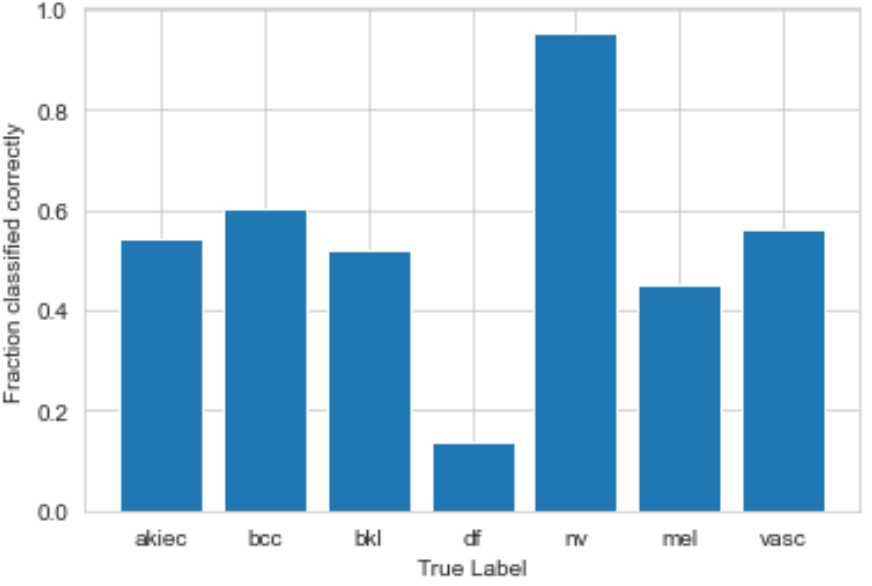
Figure 3. Percentage of correct classifications per